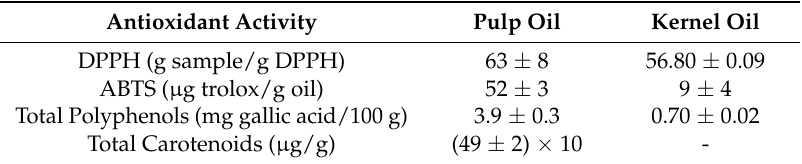
Table 3. Antioxidant ability assay by DPPH and ABTS methods and antioxidant compounds in A. aculeata